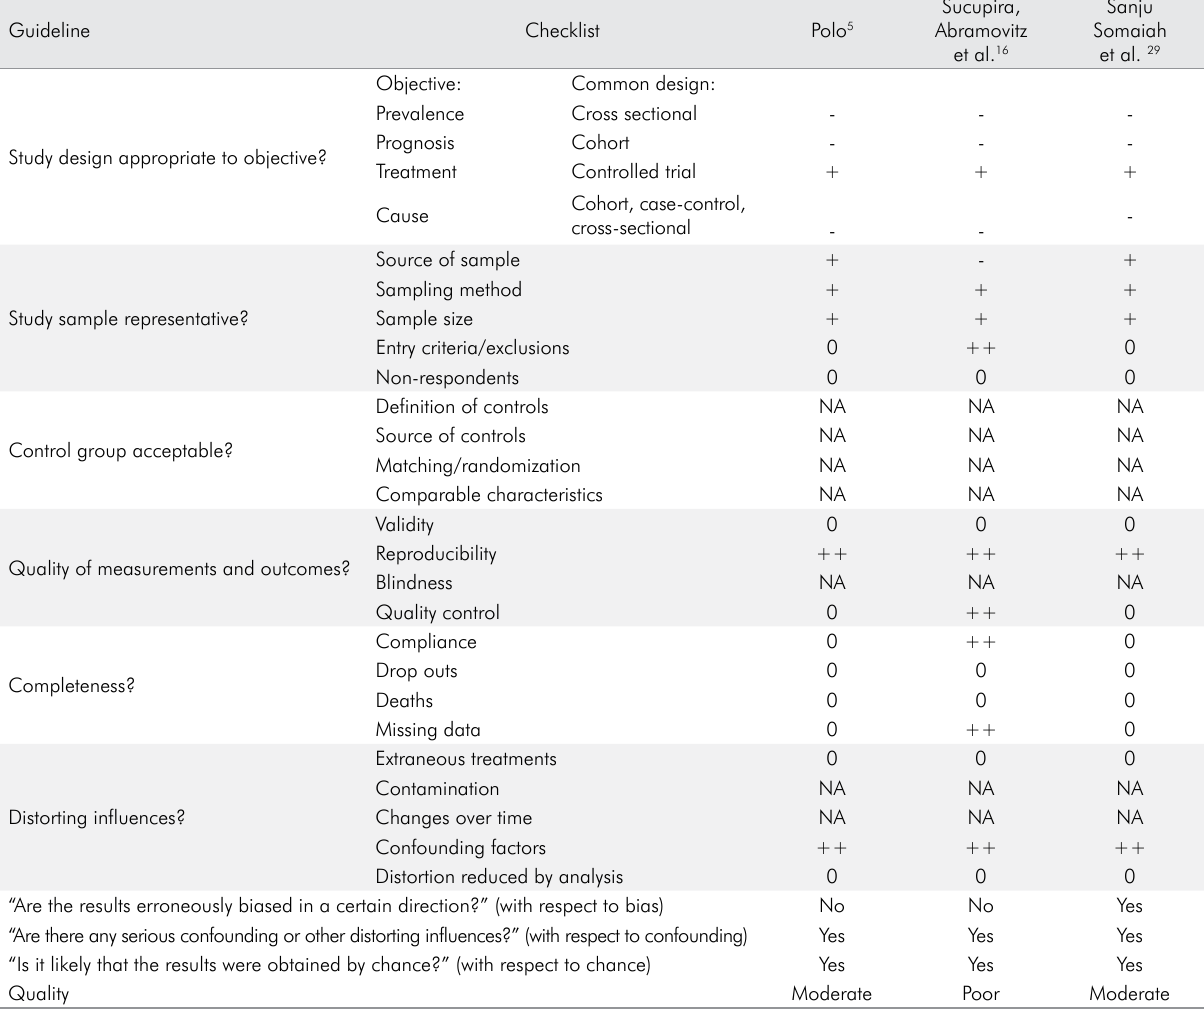
Table 3. Quality assessment of the included